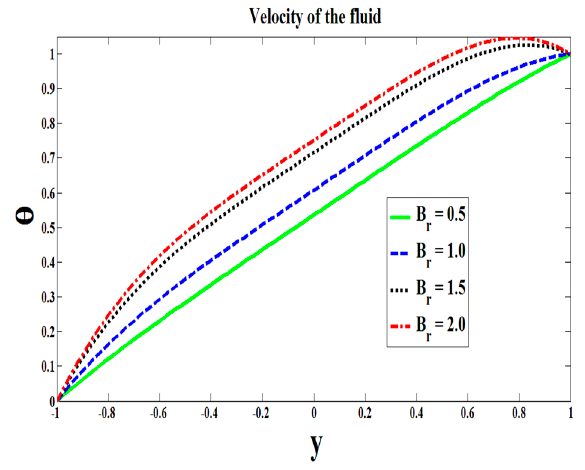
Figure 10. Role of Brinkman number on the temperature.